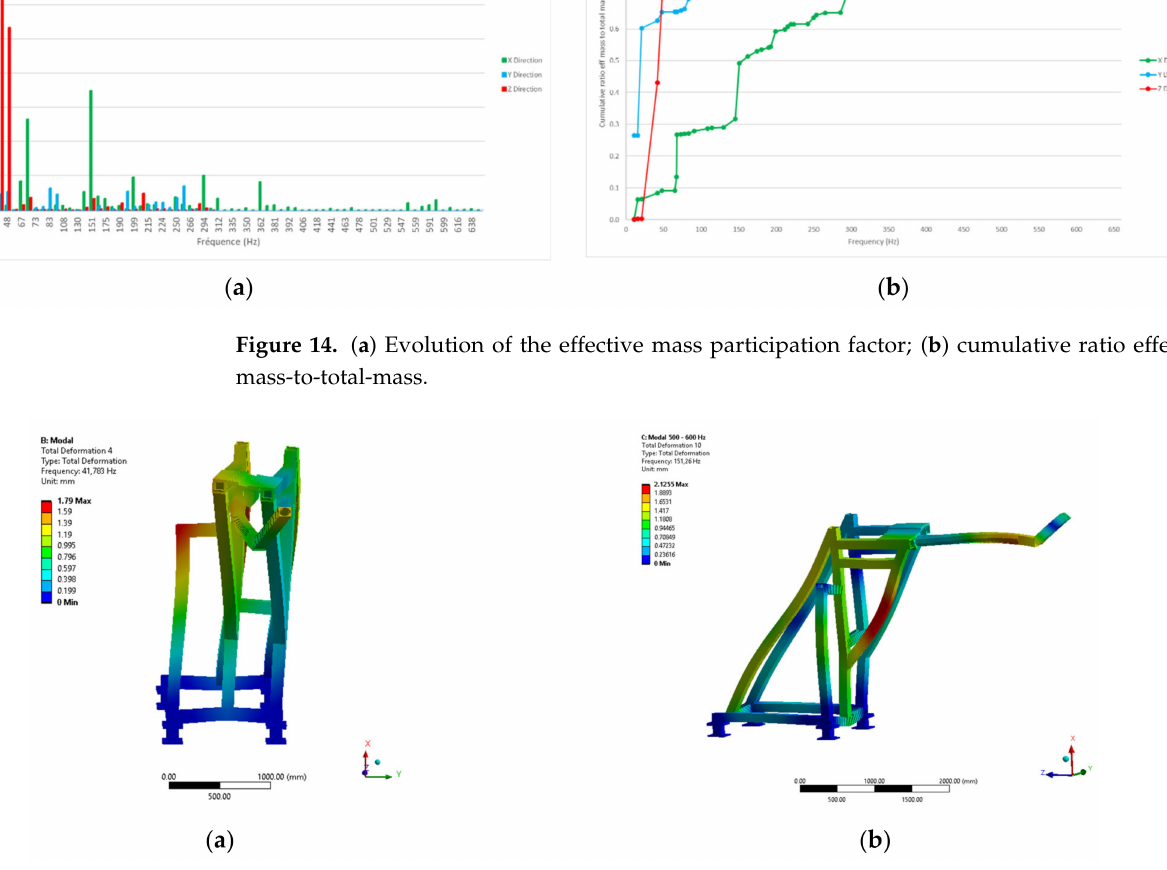
Figure 15. ( a ) Fourth mode representation—F 4 = 41.8 Hz; ( b ) Seventeenth mode representation— F 17 = 151.3